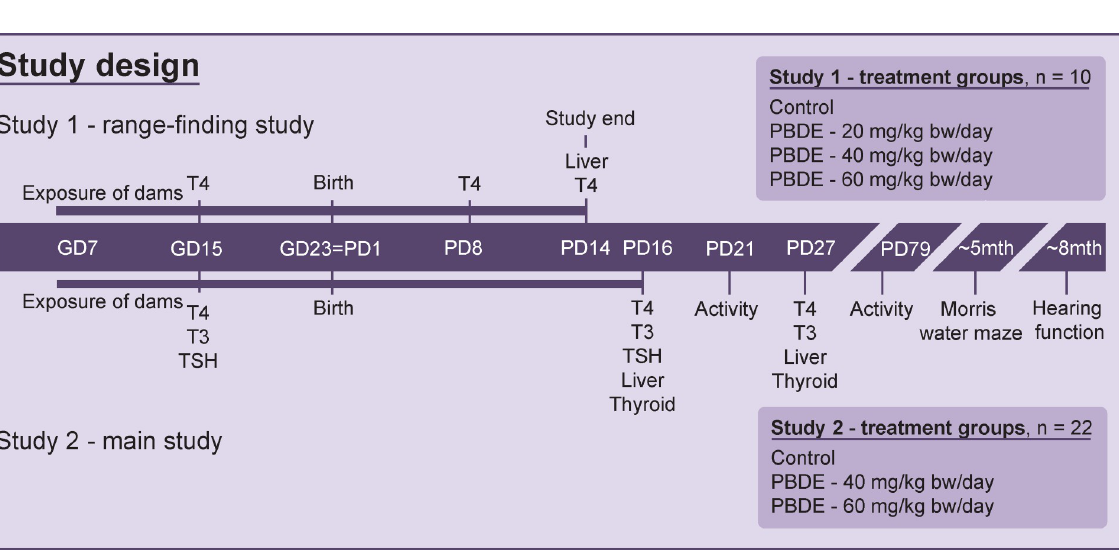
Fig 1. Study design for two developmental toxicity studies with the DE-71 technical mixture of brominated flame retardants. Study 1 assessed early postnatal thyroid hormone disruption and toxicity while Study 2 was used for examination of later postnatal thyroid hormone system disruption, liver and later in life effects on behavior, learning and hearing function. Bw: body weight, GD: gestation day, PBDE: polybrominated diphenyl ethers (DE-71), PD: postnatal day. T3: 3,3´,5-tri-iodothyronine, T4: thyroxine. TSH: thyroid stimulating hormone. The toxicity data and reproductive effects are reported elsewhere [25]. Timeline not drawn to